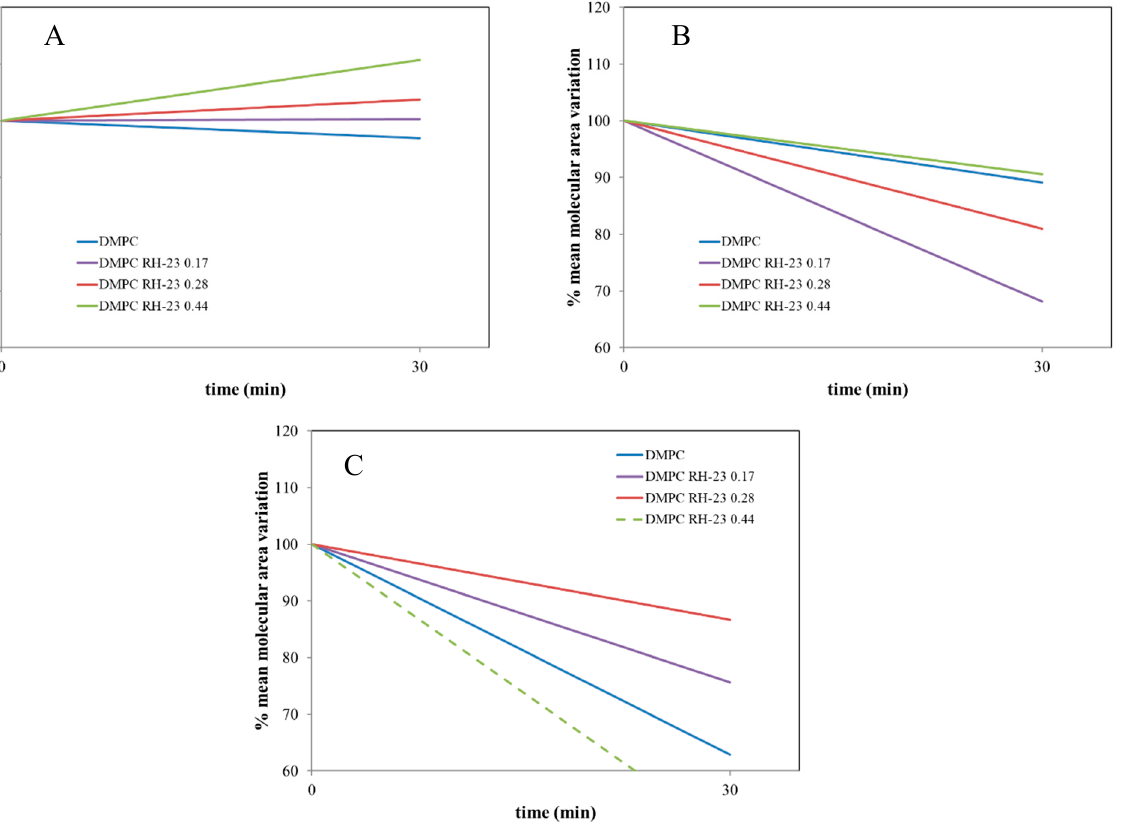
Figure 9. Percentage variations in the area per molecule of the DMPC monolayer in the presence of RH-23 at different molar fractions in the subphase during the 30 min pause at 10 mN/m ( A ), 20 mN/m ( B ) and 30 mN/m ( C ).